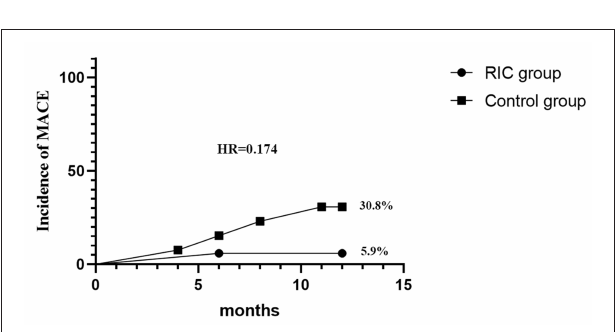
FIGURE 4 | Cumulative incidence of major adverse cerebrovascular events (MACEs) at 12